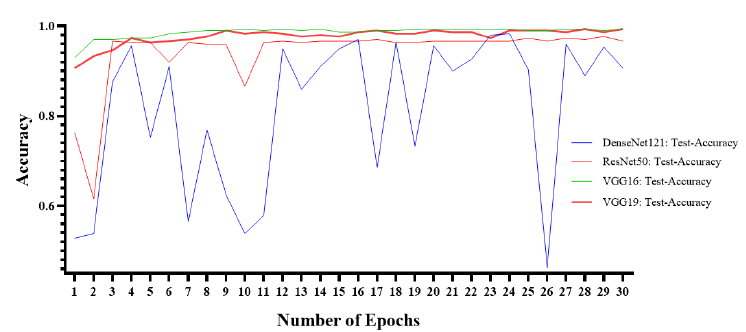
Figure 4. Training loss curve for DenseNet121, ResNet50, VGG16, and VGG19.